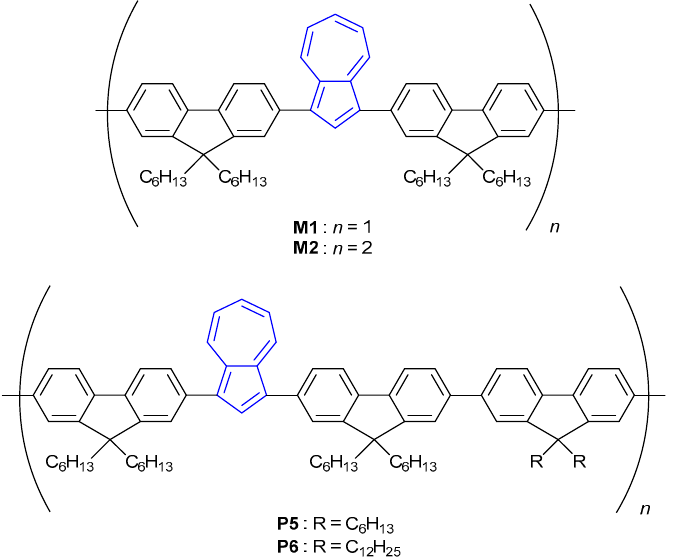
Figure 2. Monomers and polymers synthesised by Xu et al. [46].